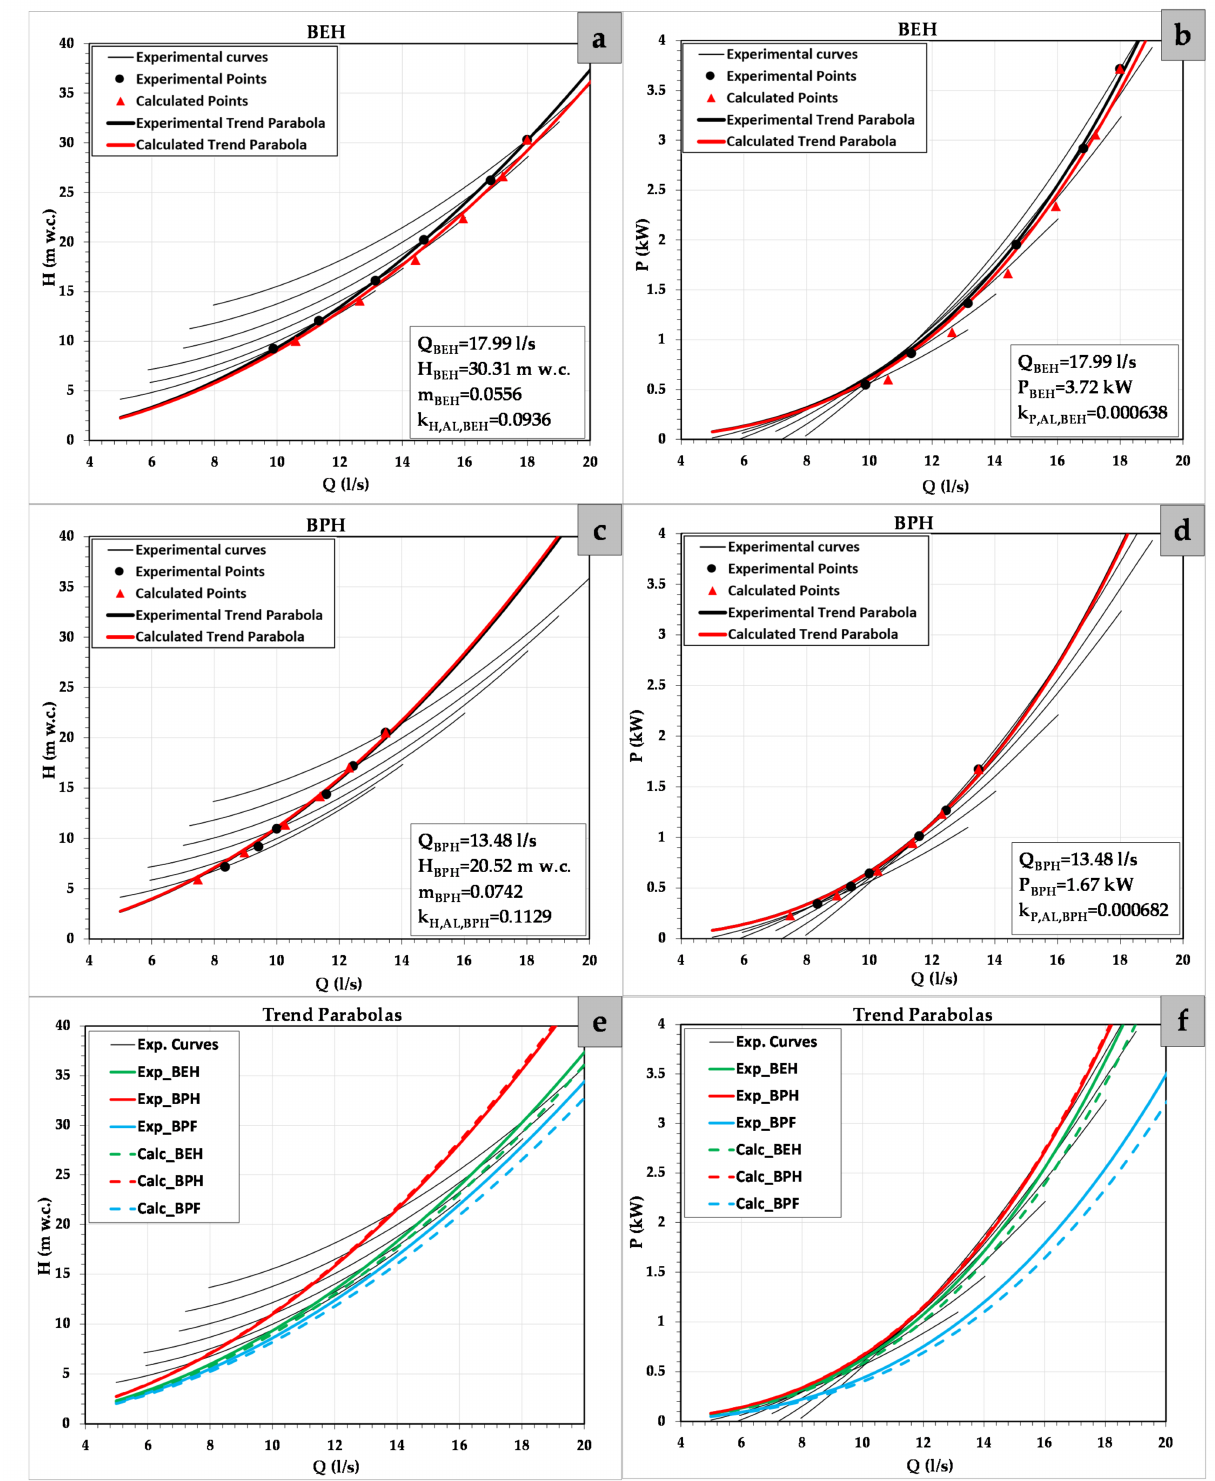
Figure 5. ( a ) H − Q for BEH ; ( b ) P − Q for BEH ; ( c ) H − Q for BPH ; ( d ) P − Q for BPH ; ( e ) H − Q for BEH , BPH and BPF ; ( f ) P − Q for BEH , BPH and BPF